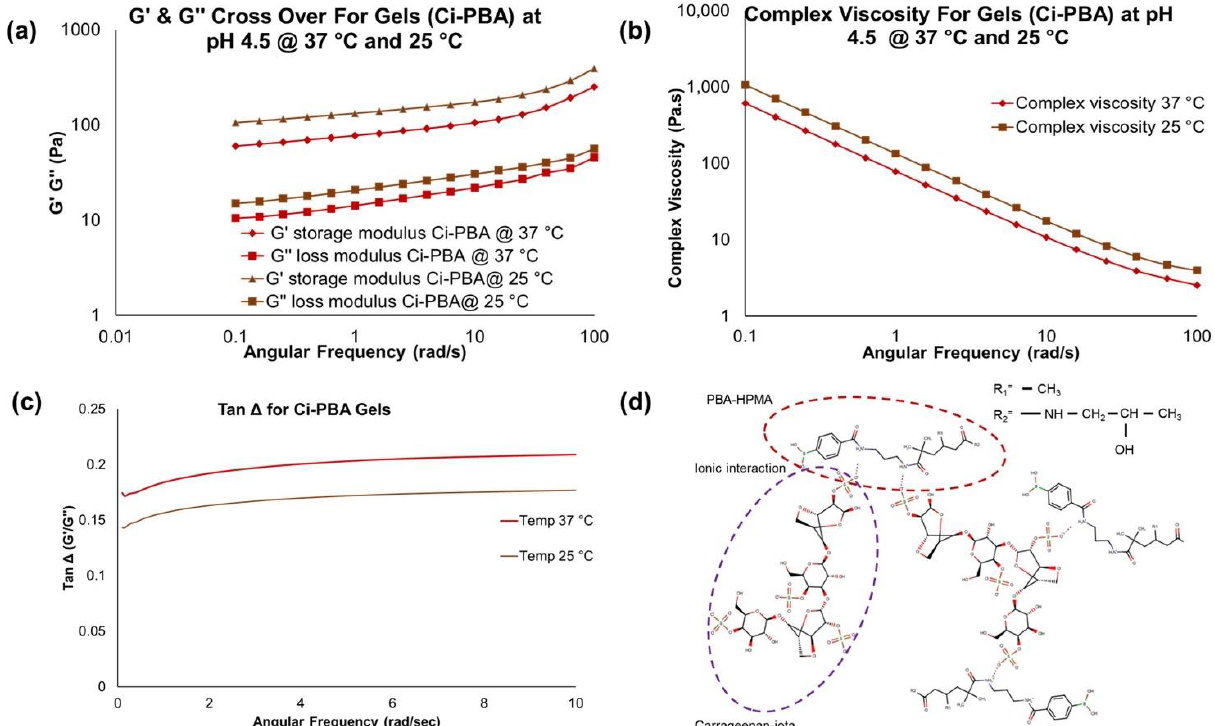
Figure 3. Physically cross-linked C i -PBA gel (Gel 2) rheology data at pH 4.5: ( a ) temperature-dependent (at 25 and 37 °C) changes in the G′ and G″ modulus profiles at varying angular frequency, ( b ) temperature-dependent (at 25 and 37 °C) changes in the complex viscosity, ( c ) Tan Δ plots, which confirming the gel was softer at 37 °C compared to 25 °C, and ( d ) ionic interaction between PBA and C i polymers in forming the C i -PBA gel. Table 1. Concentrations of C i and PBA-functionalized polymers, rheological characterizations, and physical observations of C i -PBA gels. The G′ max and G″ max values were measured at 25 °C and marked as maximum values obtained for the scans in the range of 1 to 10 rad/s.